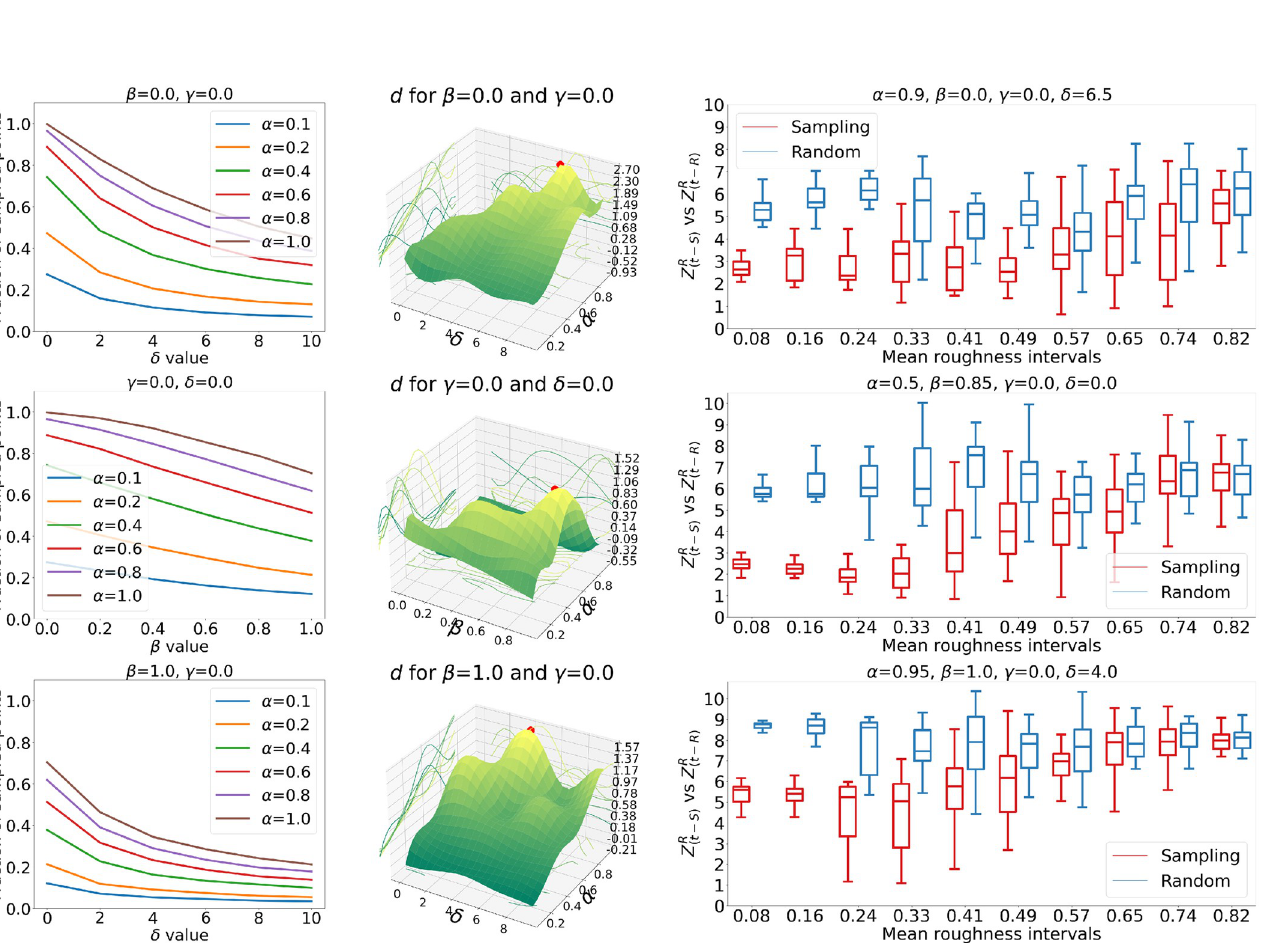
. B) Results obtained when there is no i of Z R (in red) and Z R (in blue). These plots i t (cid:0) S t (cid:0) R